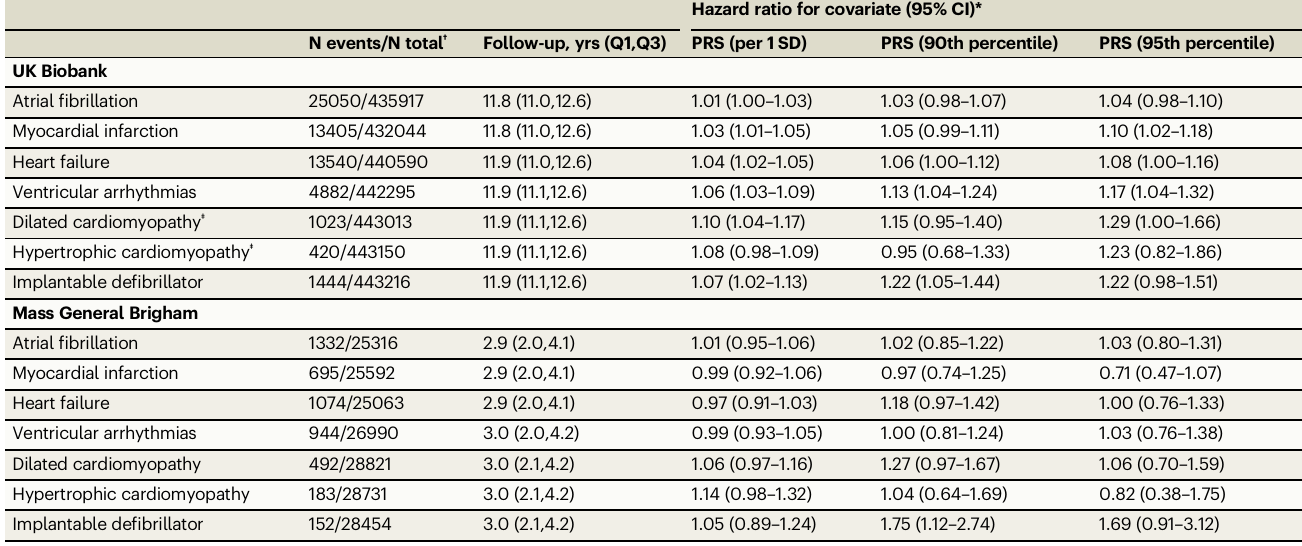
Hazard ratio for covariate (95%